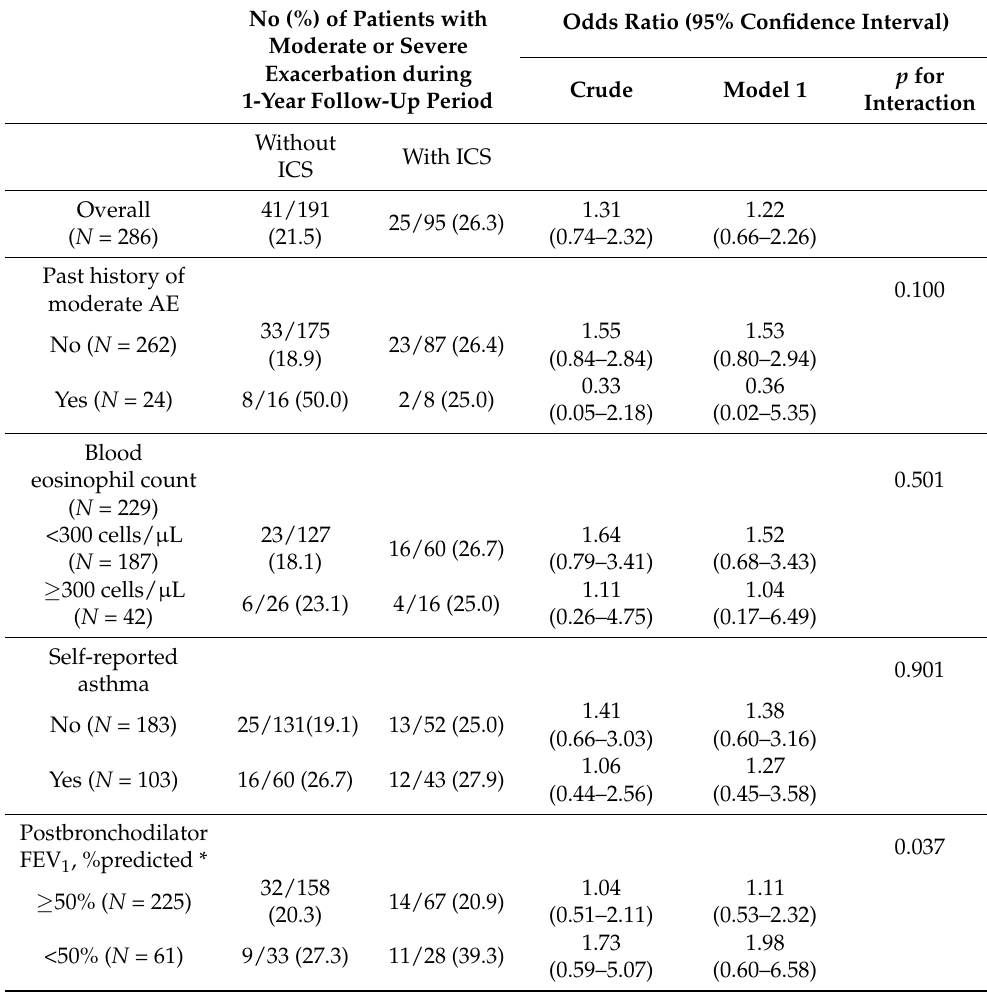
Table 3. Subgroup analysis of the risk of moderate or severe exacerbation according to ICS